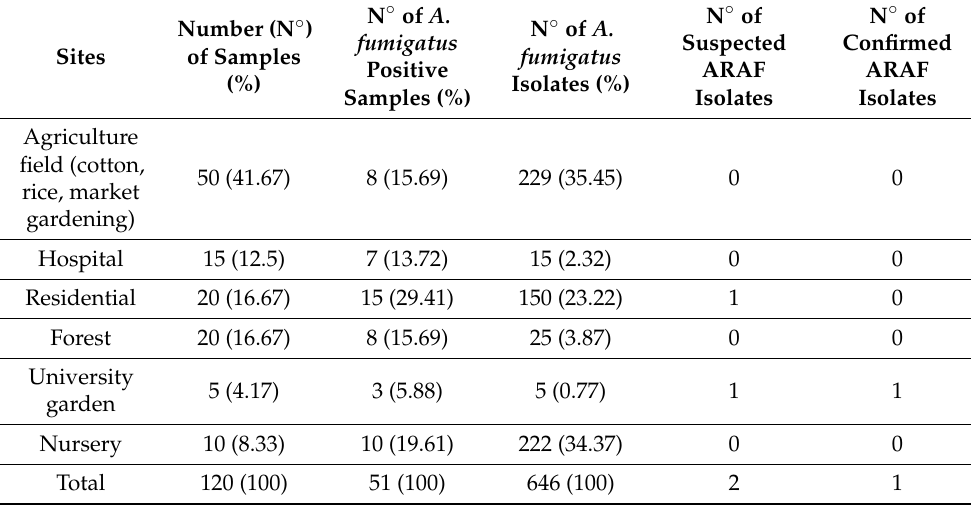
Table 1. Characteristics of A. fumigatus isolates by environmental site.